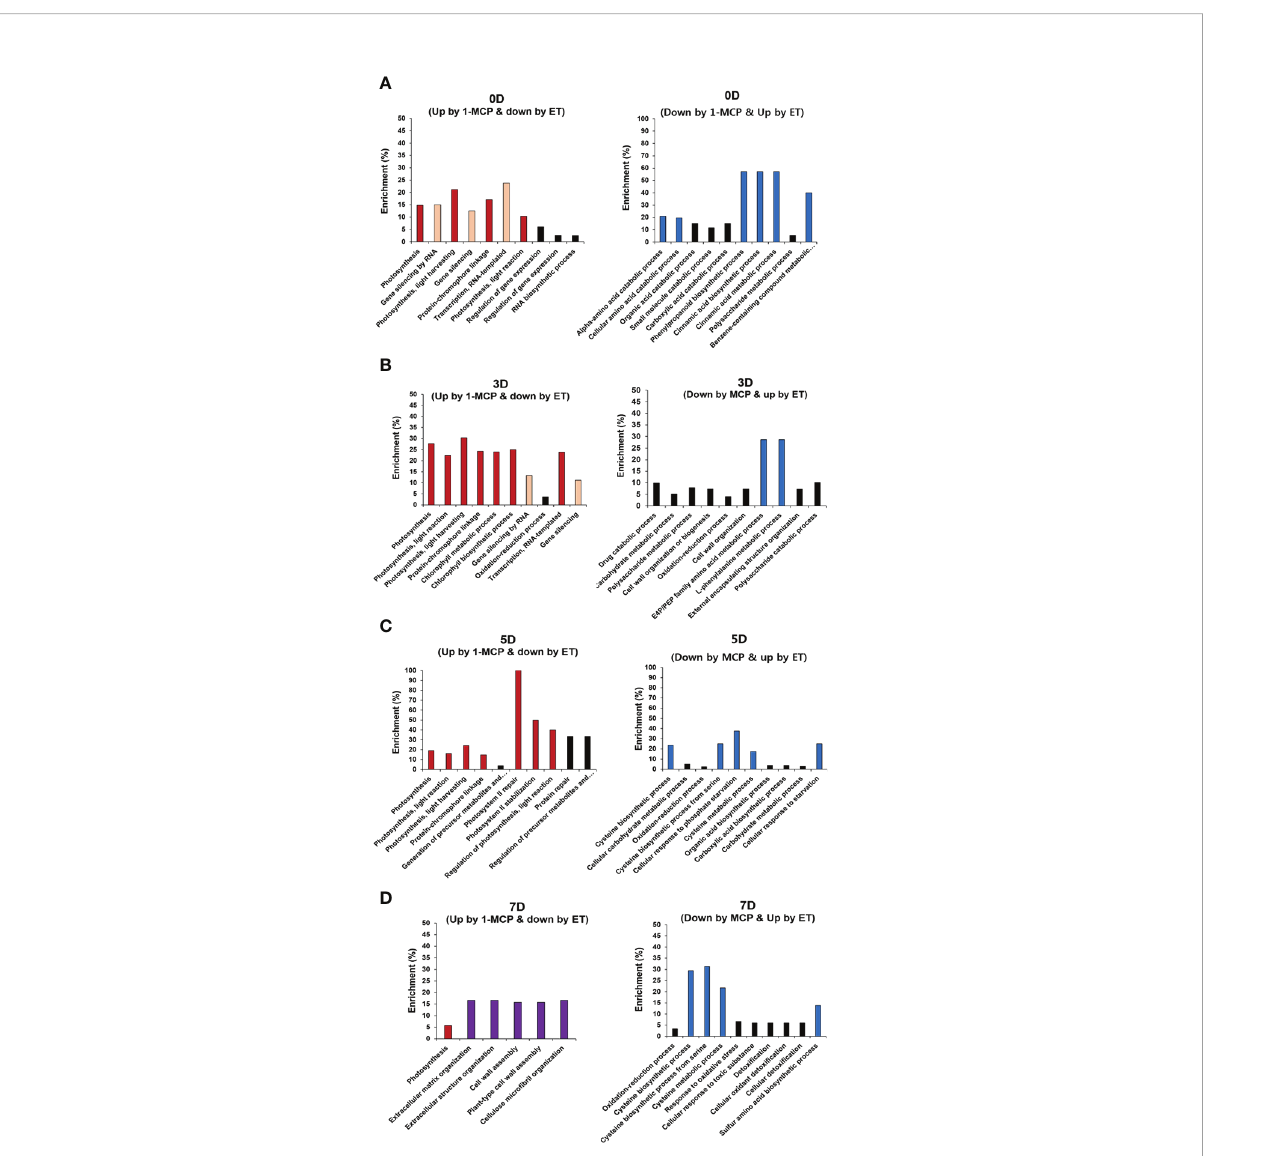
FIGURE 4 GO enrichment analysis of DEGs oppositely affected by ET and 1-MCP throughout ripening. Top 10 functional GO categories of DEGs showing inverse expression in kiwifruit exposed to ET and 1-MCP treatment and then stored for (A) 0 days (0D), (B) 3 days (3D), (C) 5 days (5D), and (D) 7 days (7D). A − D Left panels represent functional GO categories using genes showing upregulated expression by 1-MCP and downregulated expression by ET treatment, right panels represent functional GO categories using genes showing downregulated expression by 1-MCP and upregulated expression by ET. GO categories related to photosynthesis (red bars), gene silencing (yellow bars), the cell wall (purple bars), and cysteine biosynthesis (blue bars). GO, gene ontology; DEG, differentially expressed gene; ET, ethylene; 1-MCP,